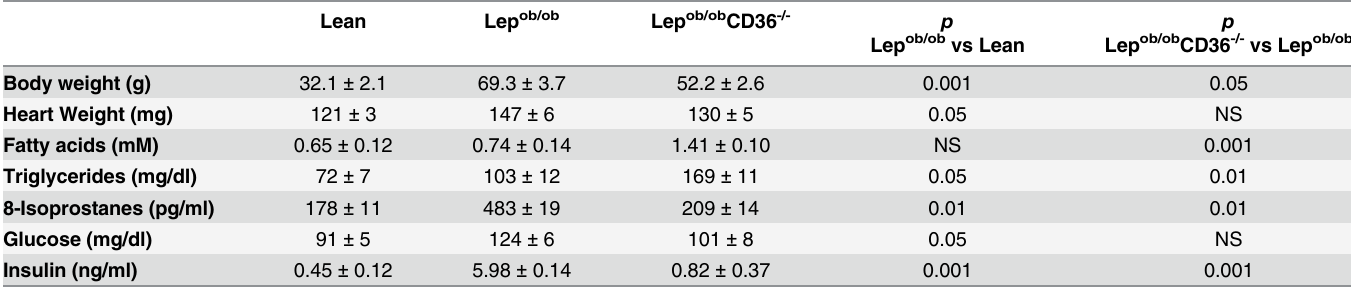
Table 1. Body and organ weights, and plasma parameters for control lean (Lean), leptin null (Lep ob/ob ) and leptin CD36 double null (Lep ob/ ob CD36 -/- ) mice. Data are expressed as mean ± SEM with n = 12 per group. Lean Lep ob/ob Lep ob/ob CD36